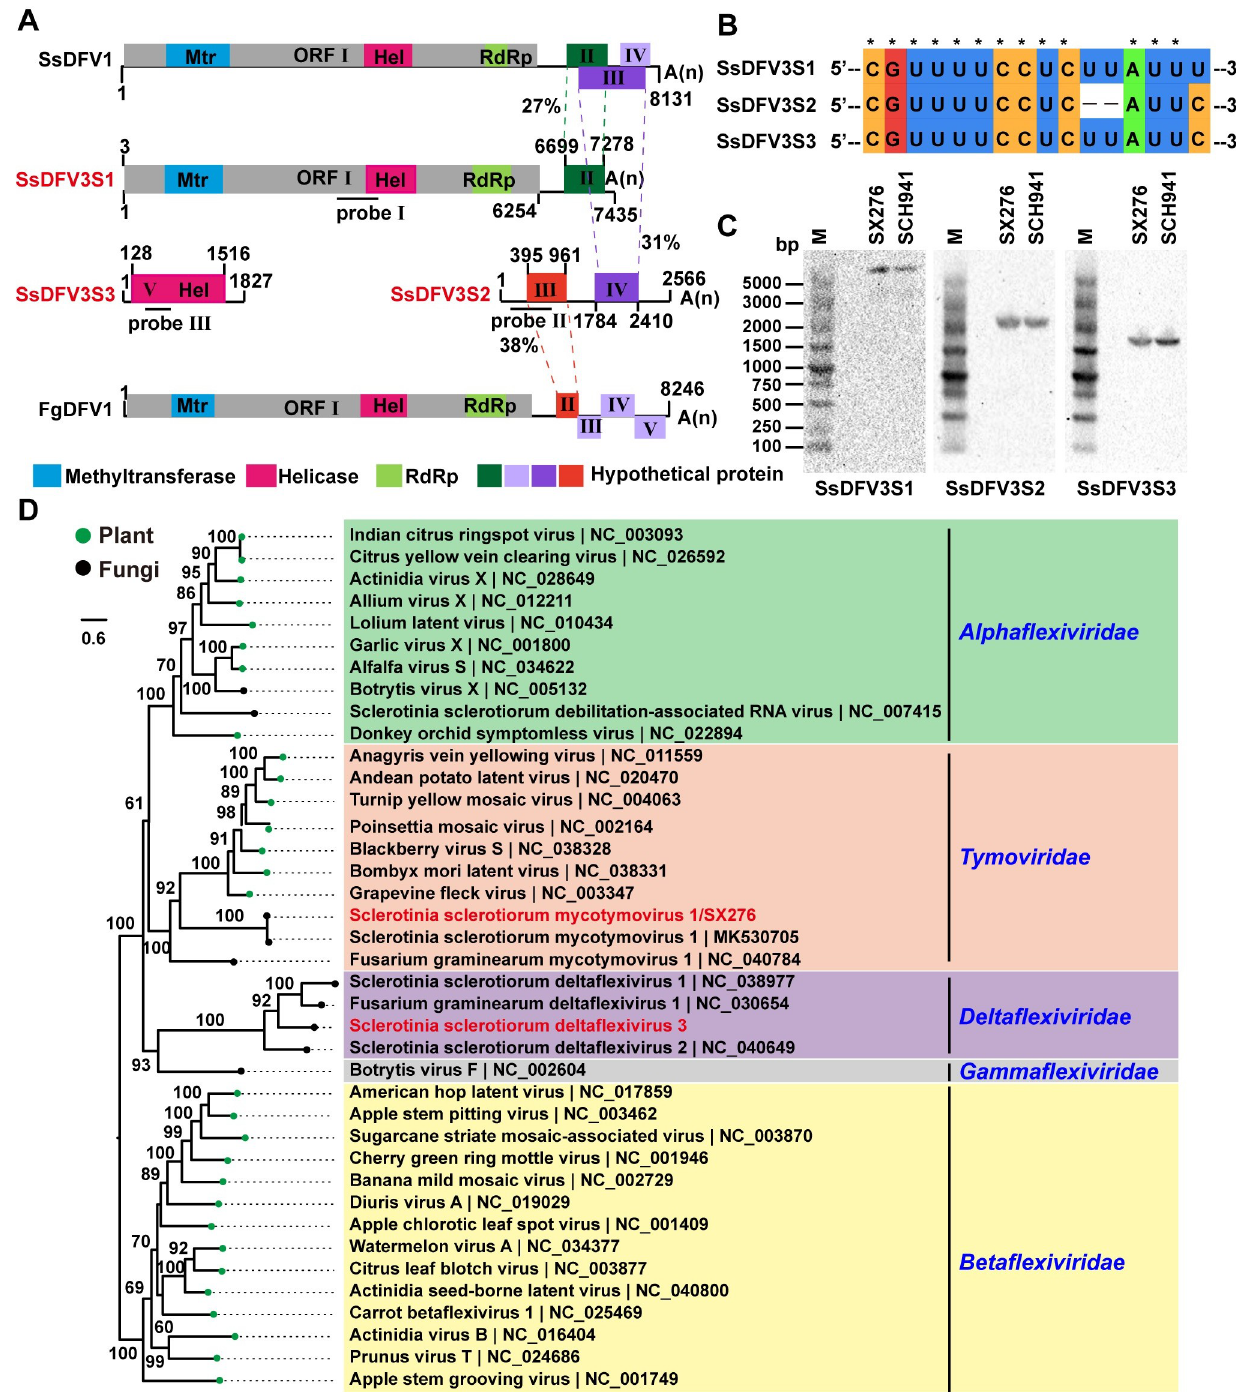
Fig 2. Genome organization and maximum likelihood tree of SsMTV1/SX276 and SsDFV3. (A) The organizations of SsDFV3 and other viruses in family Deltaflexiviridae . Open reading frames (ORFs) are shown as boxes. (B) Multiple alignments of 5 0 -terminal nucleotide sequences of the SsDFV3 genomic segments. (C) Northern blot of three segments of SsDFV3 in strain SX276 and SCH941, the probes are marked with a horizontal line in Fig 2A. (D) Maximum likelihood tree of SsMTV1/SX276 and SsDFV3 was constructed based on amino acid alignments of RdRp.